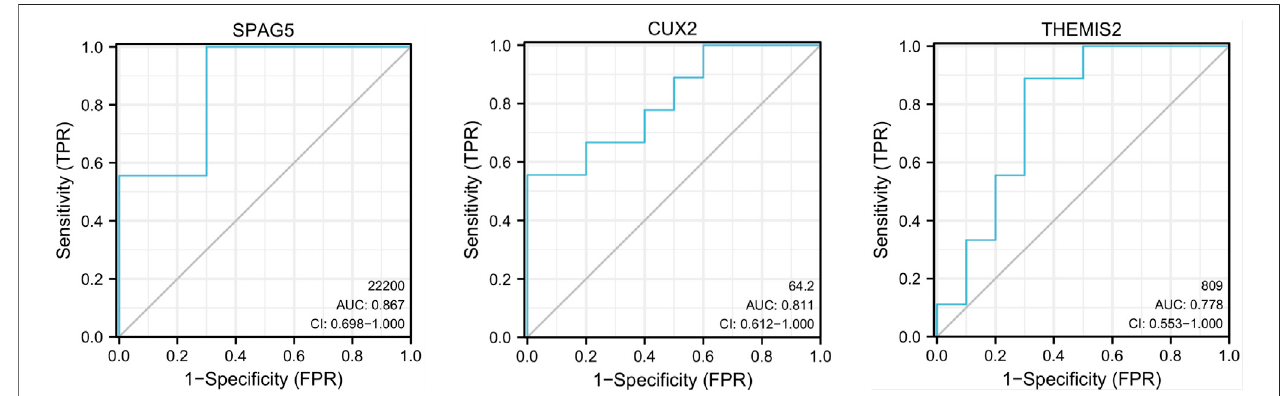
FIGURE 4 | ROC curve of the 3 speci fi cally expressed hub genes in Rheumatoid arthritis (RA) samples. AUC area under the ROC curve.